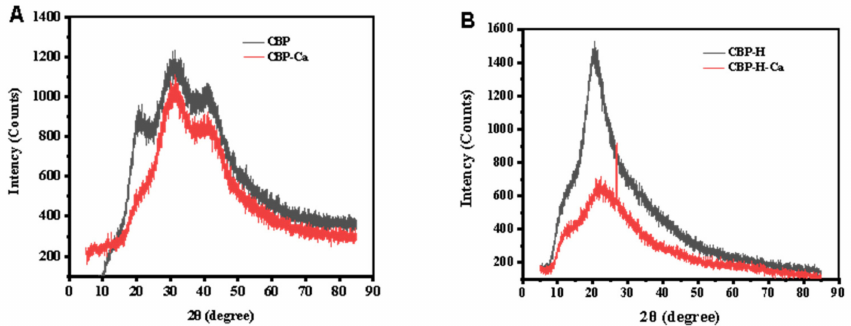
Figure 4. Conformational analysis. ( A ) XRD patterns of CBP and CBP–Ca. ( B ) XRD patterns of CBP-H and